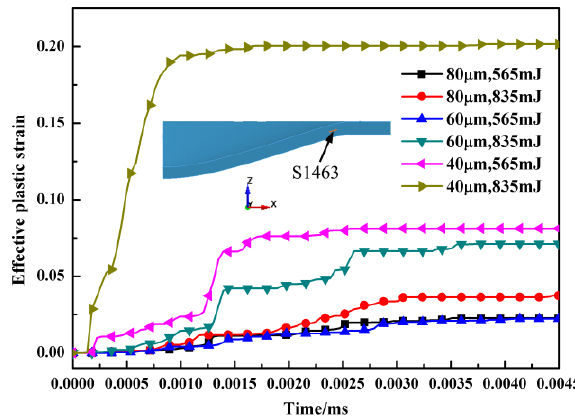
Figure 19. The variation of the equivalent plastic strain of element S1463.